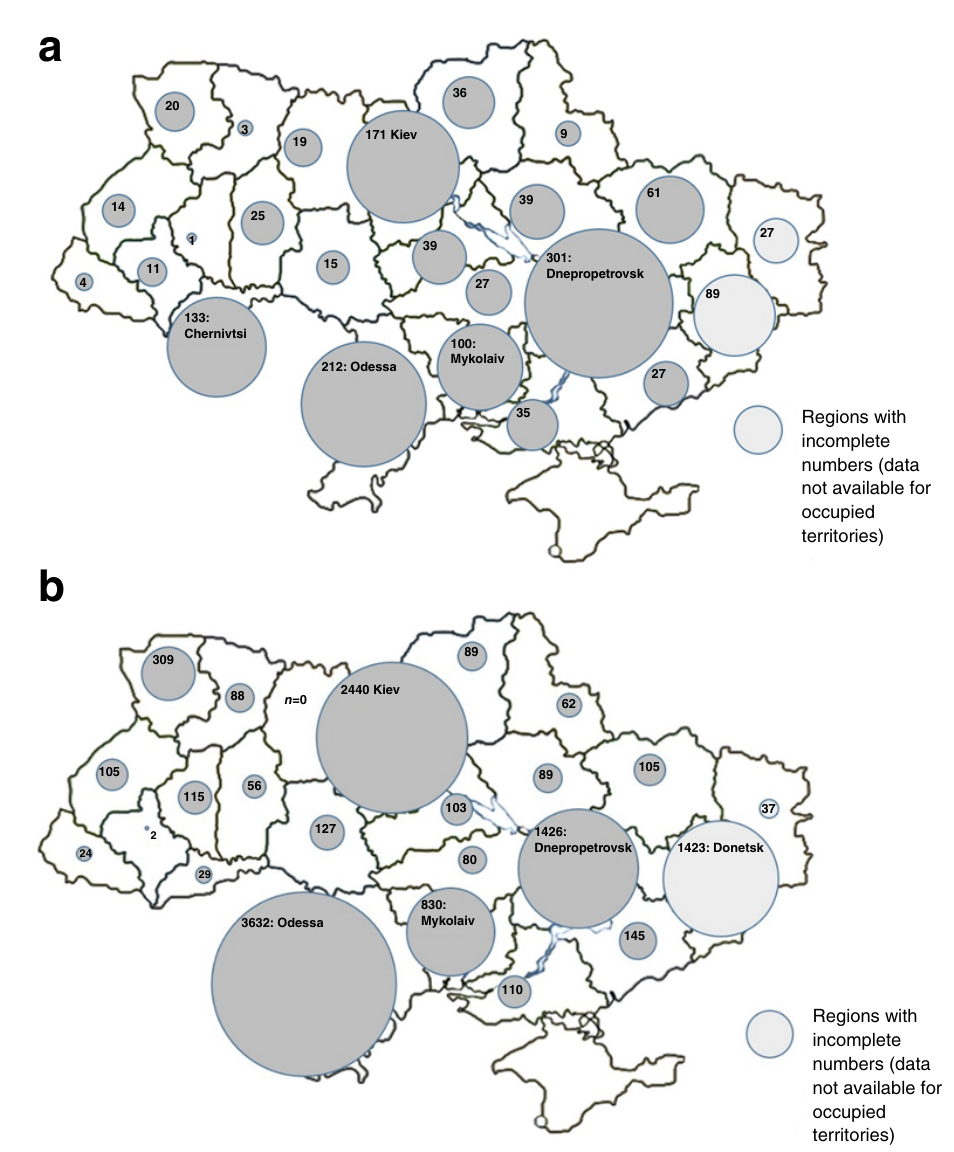
Figure 1. Maps showing ( a ) number of 10–18 year olds in paediatric HIV care and ( b ) number of 19–24 year olds in adult HIV care by region, on 1 January 2016. Area of circle is proportional to number of young people. Note different scales for maps ( a ) and ( b ). Name of region was included for centres with ( a ) n ≥ 100 10–18 year olds in paediatric services and ( b ) n ≥ 800 19–24 year olds in adult services. Maps were adapted from original versions created by Aleksandr Grigoryev, available at https://commons.wikimedia.org/w/index.php?curid=28880433 under a CC0